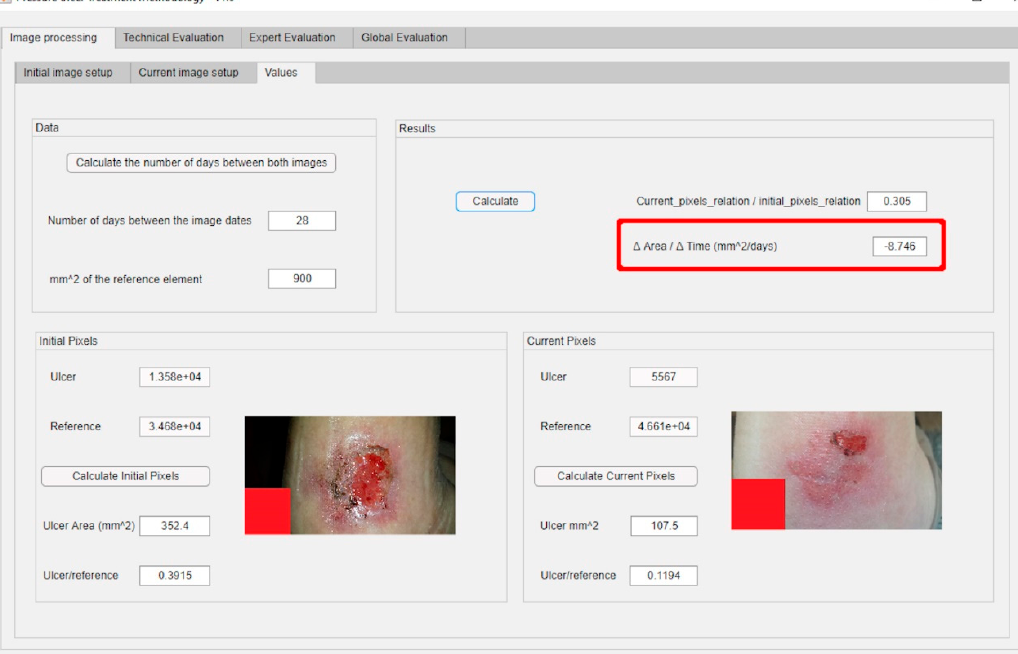
Figure 20. Output values of the image processing stage.